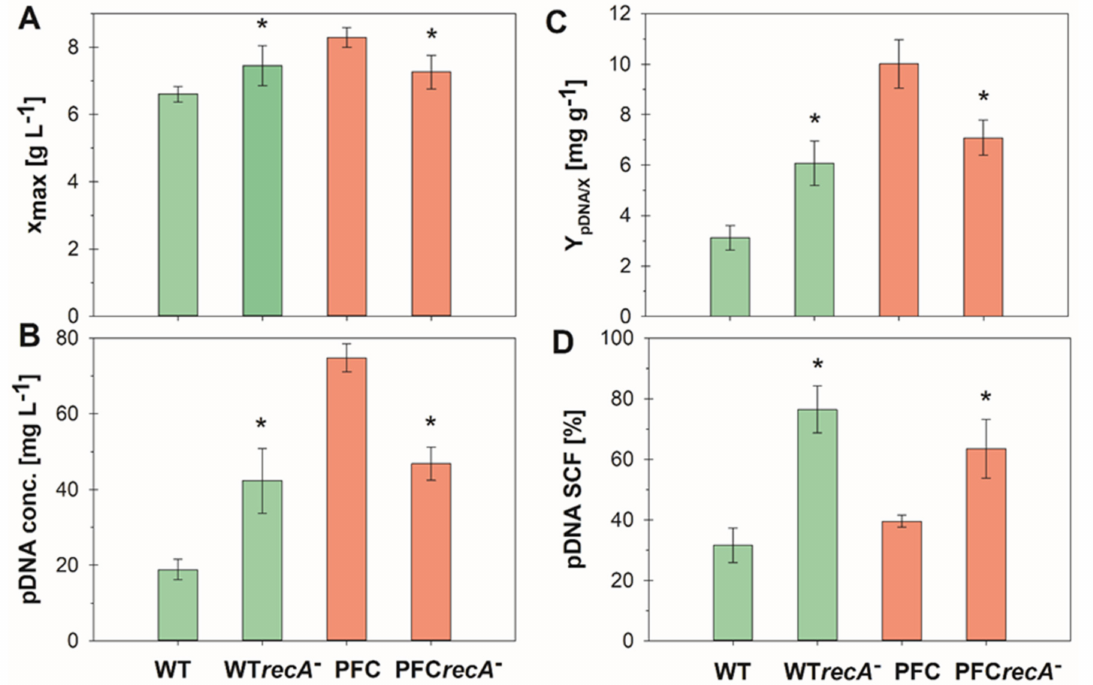
Figure 3. Main parameters of cultures of the wild type and proteome reduced (PFC) strains in fed-batch cultures in shake-flasks. Values represent the samples taken after 24 h of culture. ( A ) Maximum biomass concentration (x max ). ( B ) pDNA concentration. ( C ) pDNA yield from biomass (Y pDNA / X ). ( D ) pDNA supercoiled fraction (SFC). Error bars show the standard deviation between triplicate experiments. * indicates the groups where significant di ff erence was found ( p <